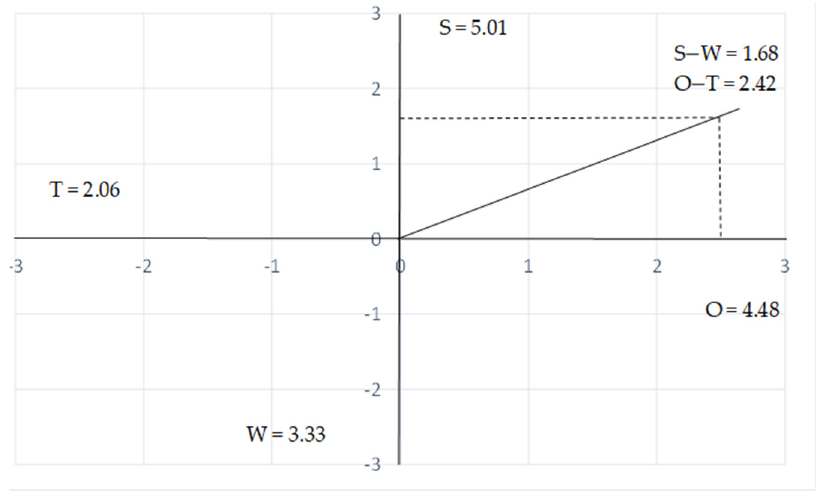
Figure 5. Map of the strength of sorghum development in Gunungkidul Yogyakarta, 2022.